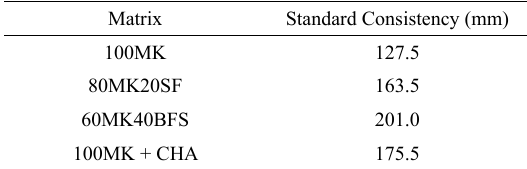
Table 4. Flow table test